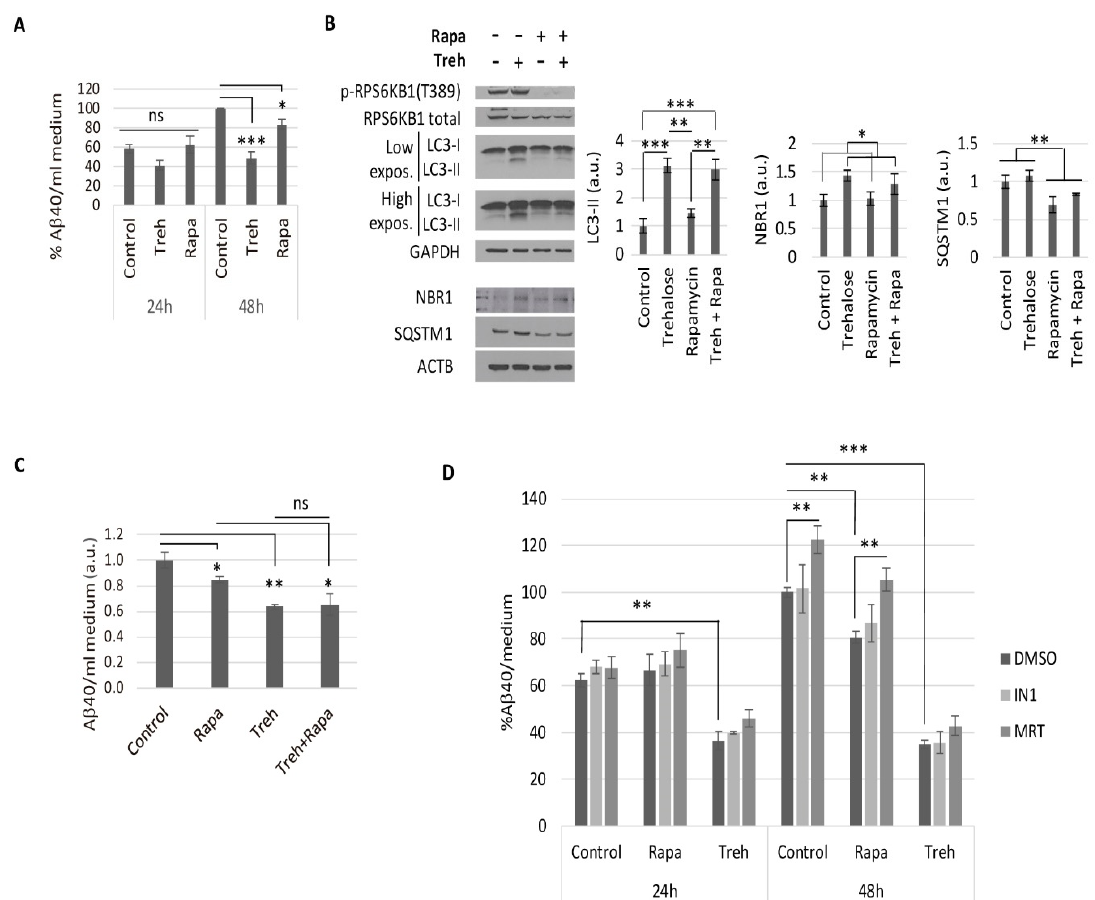
Figure 2. The reduction of secreted A β 40 in neurons by trehalose was not mediated by autophagy. The ( A ) APP/PSEN1 CGN cultures were treated with 100 mM of trehalose (Treh) or 200 nM of rapamycin (Rapa) for 24 or 48 h, and A β 40 levels were detected in culture media by ELISA. Two-way ANOVA was performed ( n ≥ 4). The ( B , C ) APP/PSEN1 CGN cultures were treated with 100 mM of Treh or 200 nM of Rapa for 48 h. The ( B ) cell extracts were analyzed by western blot. NBR1, SQSTM1, and LC3-II were measured to determine the autophagic status, with p-RPS6KB1 T389 as an indicator of MTORC1 activity, and ACTB and GAPDH as internal controls. Two-way ANOVA was performed ( n = 3). The ( C ) A β 40 levels in the culture media were detected by ELISA. Two-way ANOVA was performed ( n = 3). The ( D ) A β 40 levels in culture media were determined by ELISA after 24 or 48 h of treatment with 100 mM of Treh in the presence or absence of the inhibitors of autophagosome formation PIK3C3/VPS34-inhibitor 1 (IN1) or MRT68921 (MRT) (24 h: 0.25 μ M of IN1 or 0.5 μ M of MRT; 48 h: 0.1 μ M of IN1 or 0.1 μ M of MRT). Two-way ANOVA was performed for 24 and 48 h of treatment (n ≥ 3). (ns: